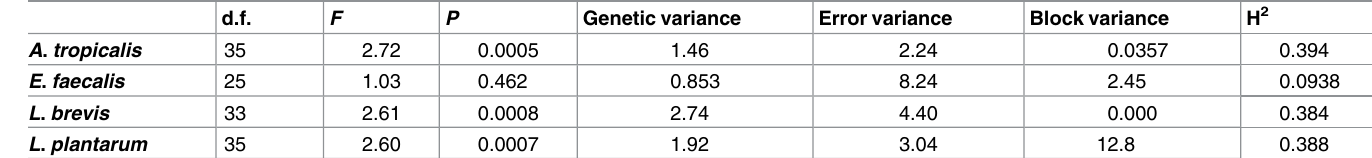
Table 1. Significant genetic variation and heritability in abundance of commensal gut bacteria across DGRP lines of Drosophila . d.f.